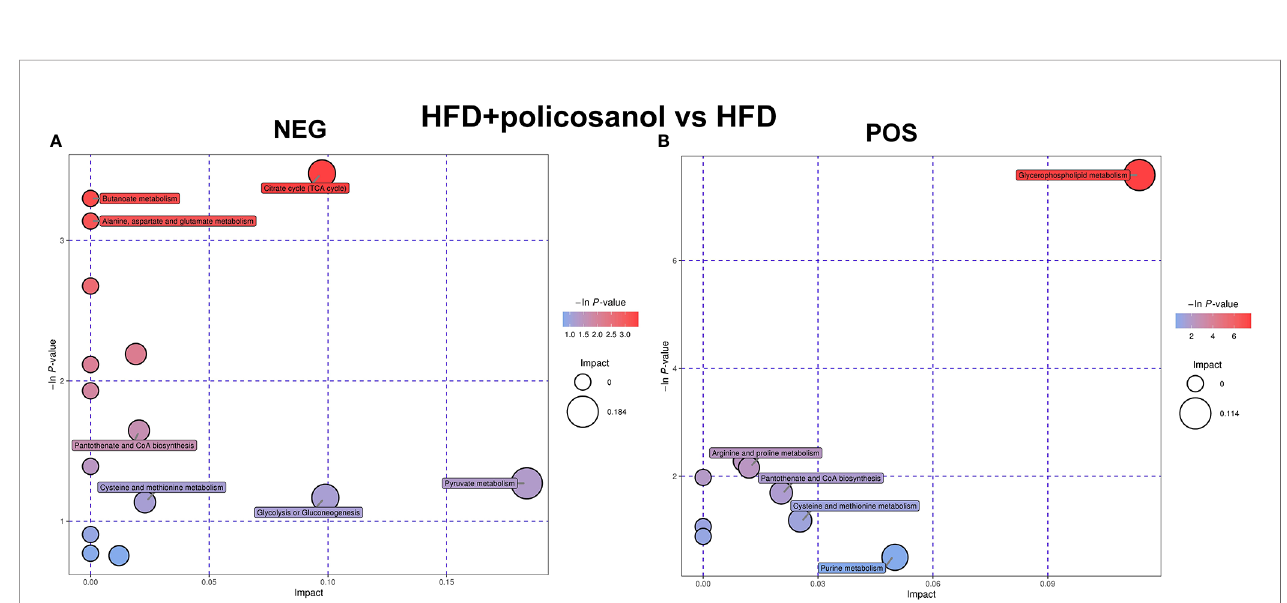
FIGURE 5 | Policosanol regulates the metabolic pathways in obese mice. (A) Enrichment analysis of KEGG pathways in NEG mode. (B) Enrichment analysis of KEGG pathways in POS mode. NEG, negative scanning mode; POS, positive scanning mode.